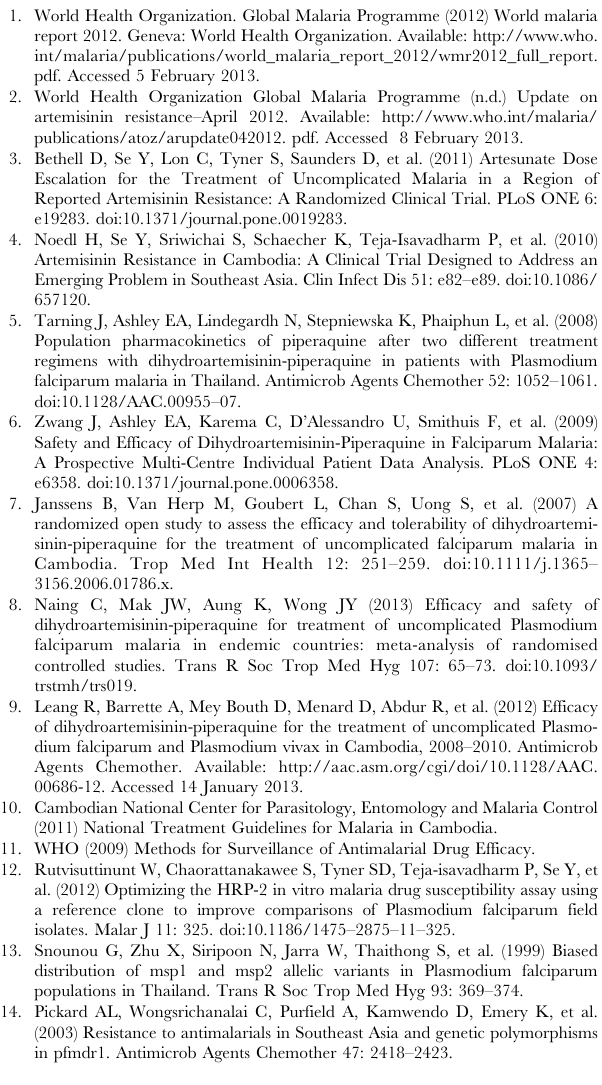
displayed below in black, while blue symbols/text represent IC 50 and mean IC 50 at baseline respectively of parasites from recurrences. Mean differences in IC 50 between paired samples are displayed as ‘‘ D = ’’. Table S1 Pvmdr1 copy number in initial and recurrent vivax